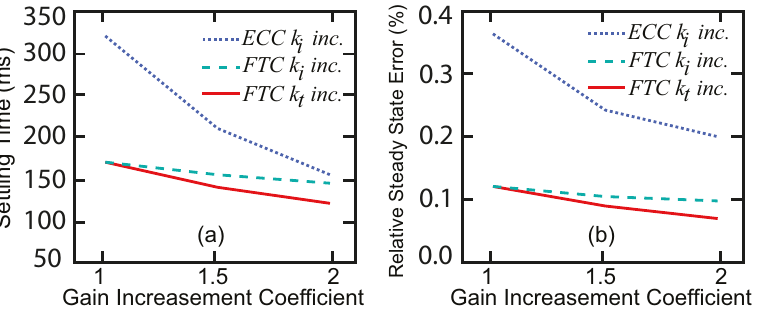
Figure 13. Effects of an increase in k i and k t on responses of the perturbed WTG with the FTC and ECC: ( a ) settling time and ( b ) relative steady-state error.